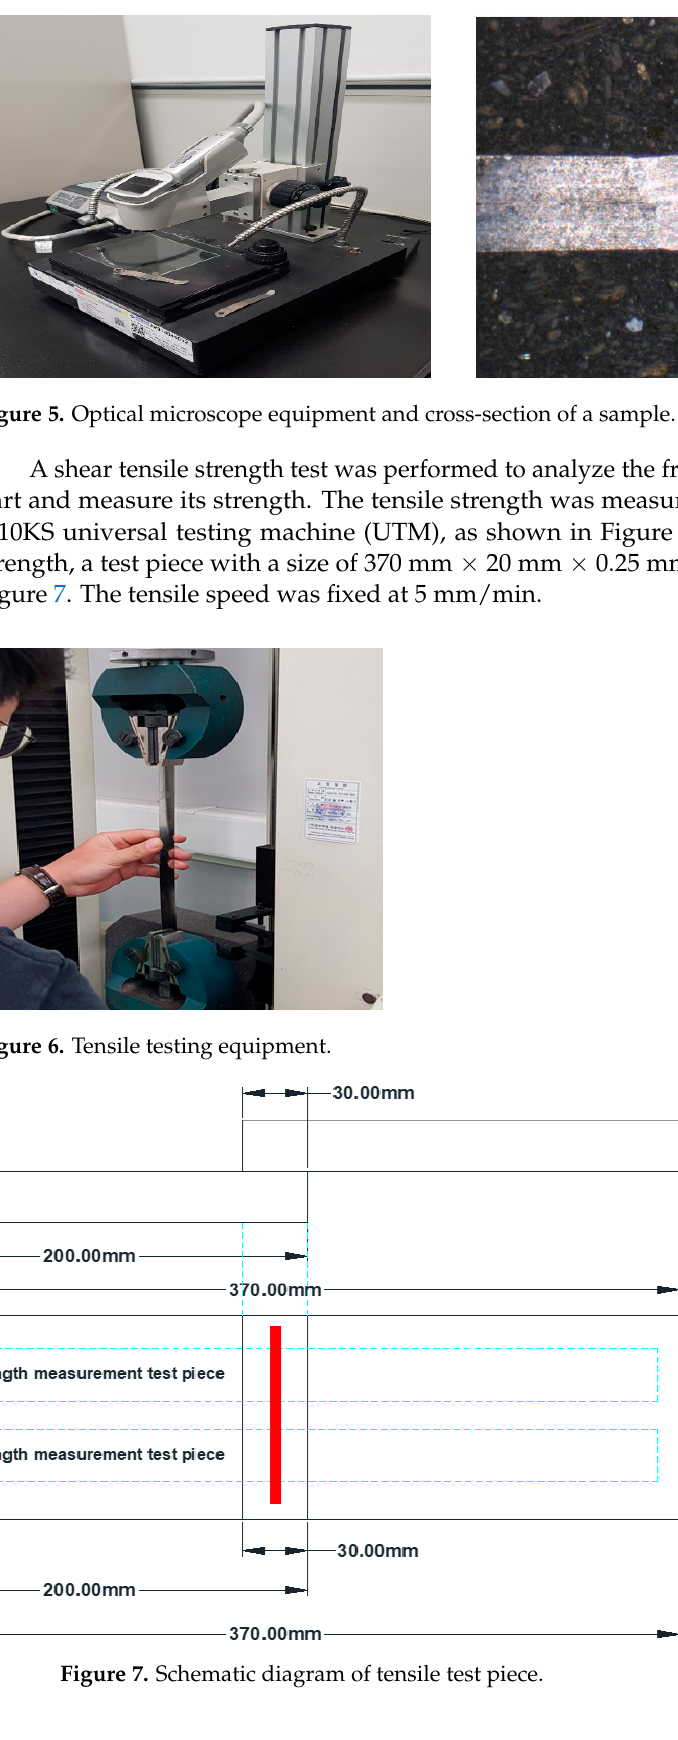
Figure 7. Schematic diagram of tensile test piece.